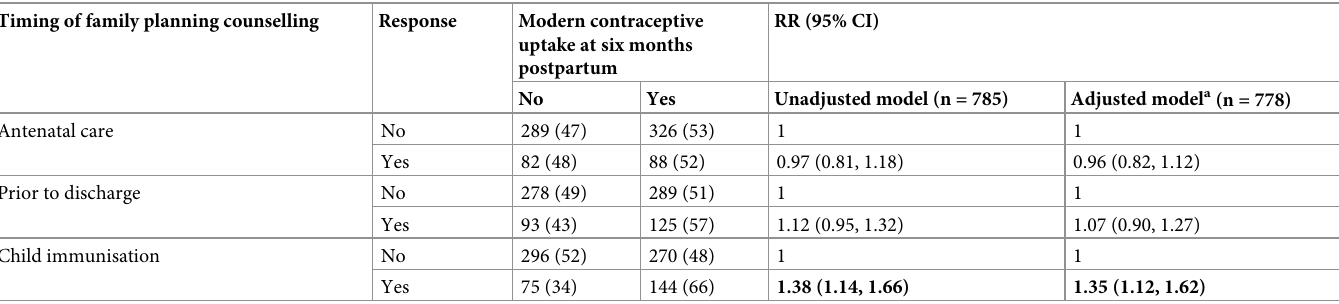
Table 4. Association between family planning counselling during the maternal health services and modern contraceptive uptake at six months postpartum. Timing of family planning